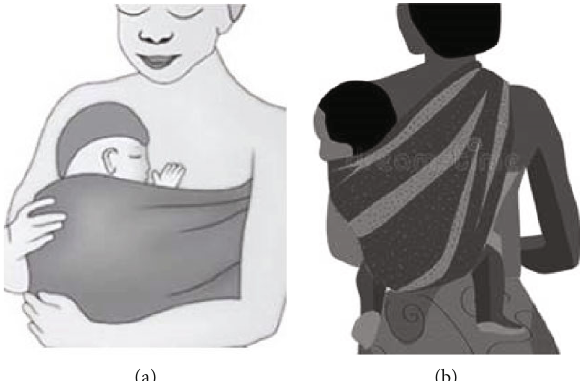
Figure 3: Pictorial representation of kinds of skin-to-skin contacts. (a) Represents the CC-SSC, and (b) represents the CB-SSC.